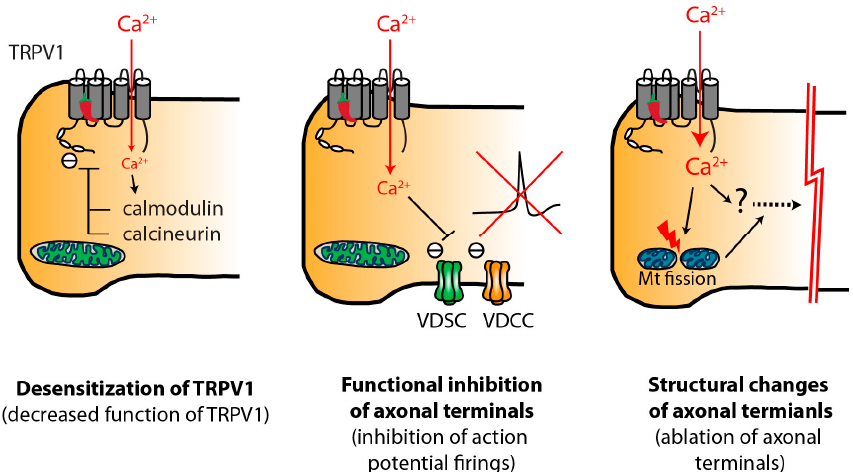
Figure 1. Responses of peripheral terminals of TRPV1-expressing nociceptors following focal injection or topical application of vanilloids. Locally administered capsaicin or RTX induces functional and, potentially, structural changes in nociceptive terminals. With therapeutic doses of capsaicin, these changes are reversible through regenerative mechanisms, and are likely localized to the nerve terminals without affecting the soma. Structural ablation of axonal terminals might play major roles in long-lasting analgesia. TRPV1, transient receptor potential vanilloid subtype 1; VDSC, voltage-dependent sodium channels; VDCC, voltage-dependent calcium channels; Mt, mitochondria.